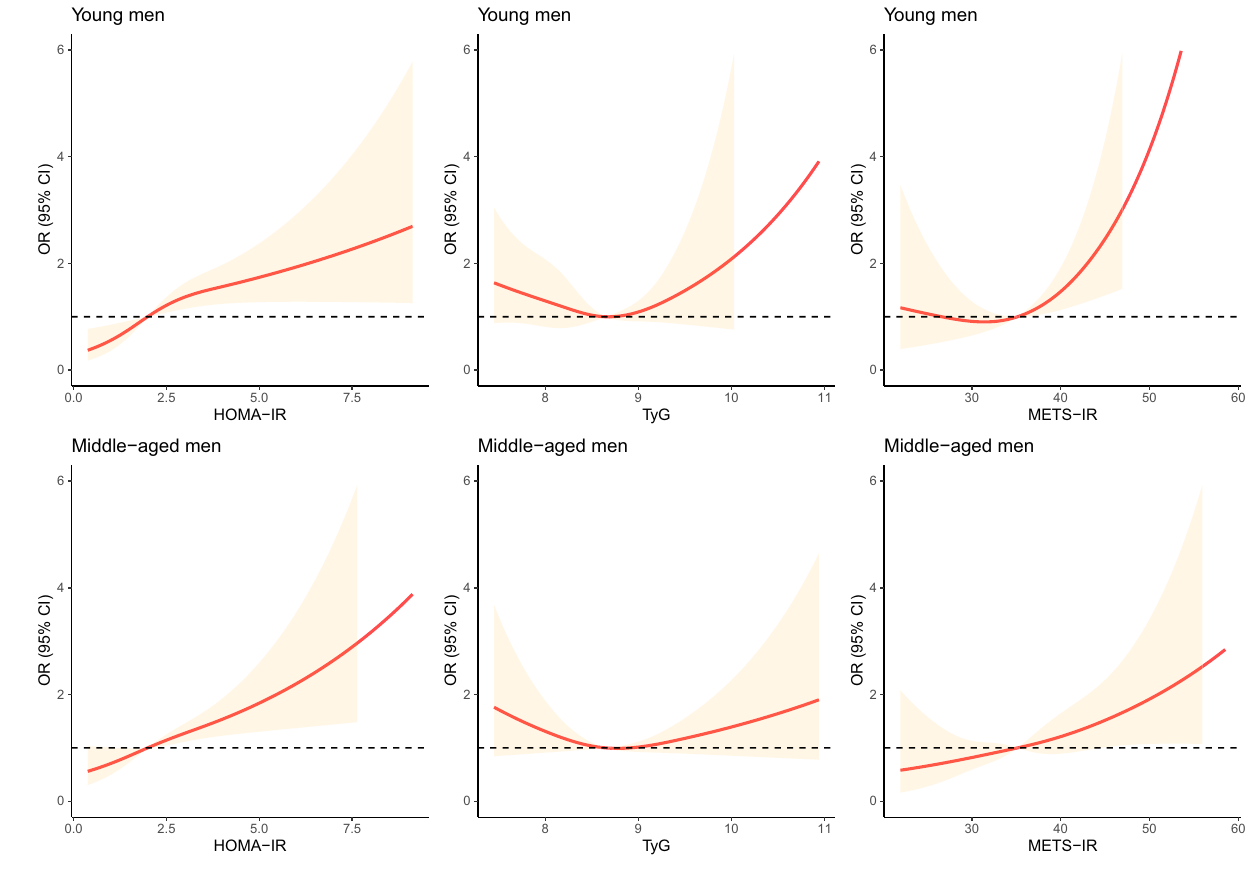
Figure 3. Fully adjusted association between insulin resistance indicators and ISH using cubic smoothing splines. OR Odds ratios, ISH isolated systolic hypertension, HOMA-IR homeostasis model assessment for IR index, TyG triglyceride glucose index, METS-IR metabolic score for IR; adjusted for abdominal obesity, non- alcoholic fatty liver, hyperuricemia, smoking, and